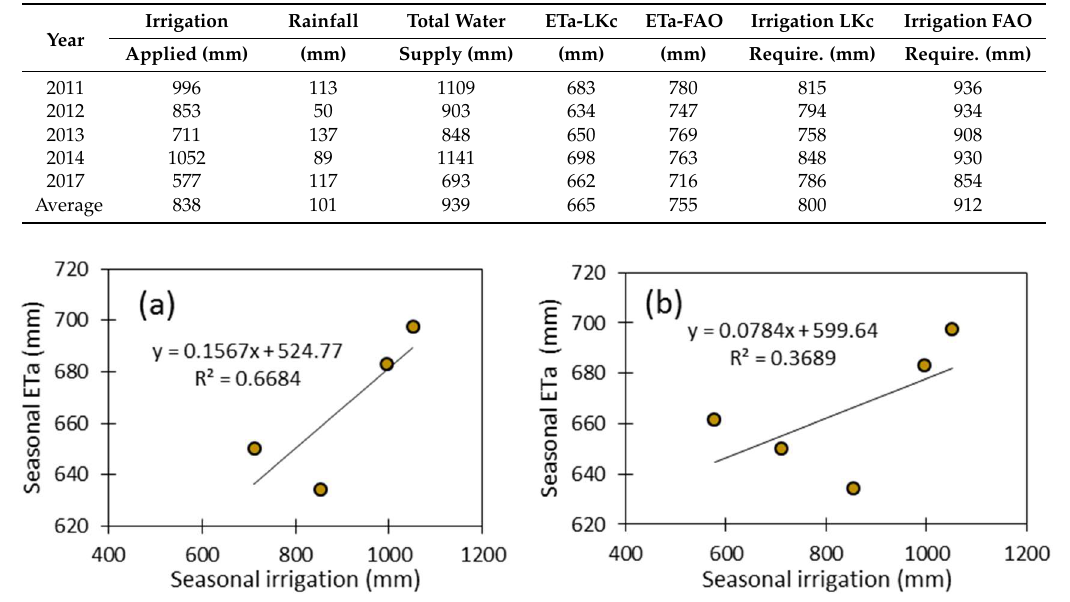
Figure 4. Relationship between maize actual evapotranspiration and thermal units during the growing seasons 2011, 2012, 2013, 2014 and 2017 and the five seasons pooled data. Table 3. Seasonal water supply and crop evapotranspiration during the five growing seasons. [ETa-LKc is ETa estimated using locally developed Kc curve (Equation (2)); ETa-FAO is ETa estimated using adjusted tabulated FAO crop coefficients, irrigation LKc is estimated using ETa-LKc, irrigation FAO is estimated using ETa-FAO].